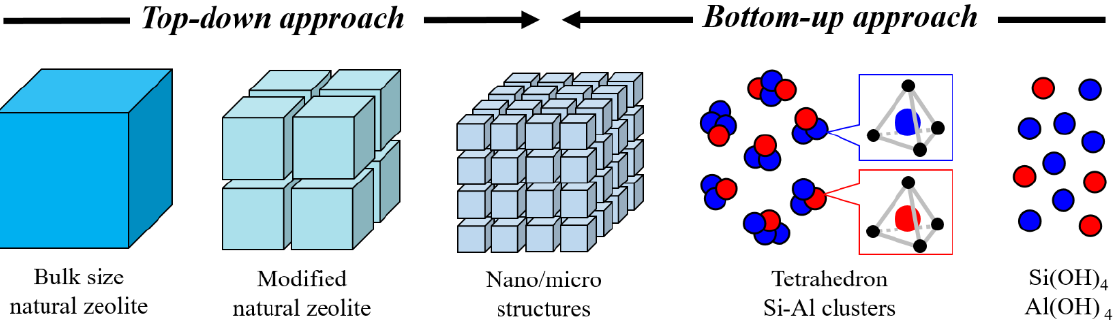
Figure 1. Schematic diagrams of “top-down and bottom-up approaches” for the synthesis of hierarchical porous zeolites.